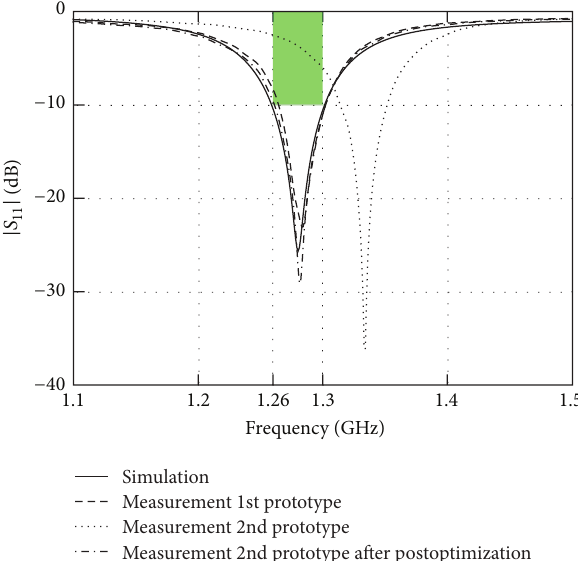
Figure 3: Constrained Pareto front resulting from the E6-band antenna optimization (constraints imposed: AR < 3 dB and |𝑆 11 | < −10 dB). Table 1: Dimensions of the optimized antenna. Parameter Value [mm] 𝐿 patch